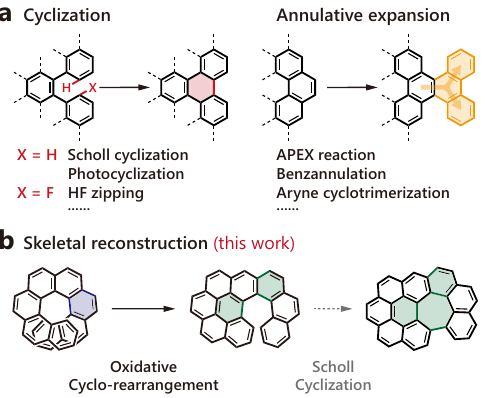
Fig. 1 General synthetic strategies for nanographenes. a Traditional cyclization and annulative expansion strategies. b Skeletal reconstruction method developed in this